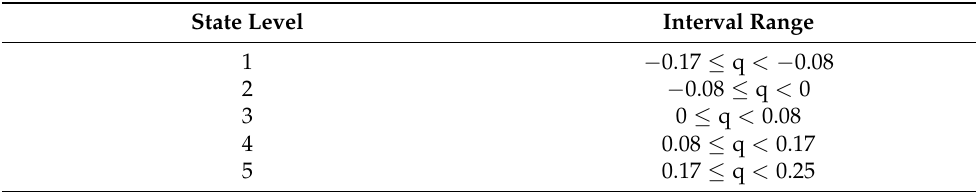
Table 9. State level division of residual relative value (q).